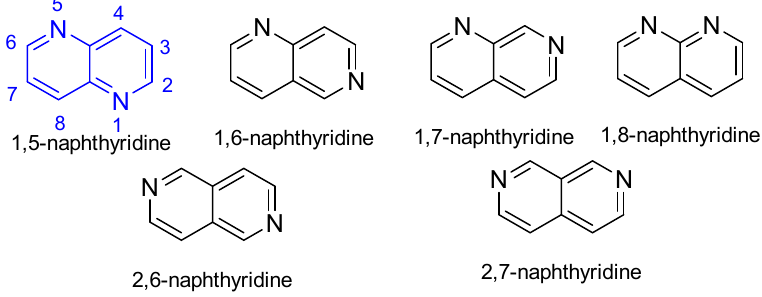
Figure 1. Structures of isomeric naphthyridines.